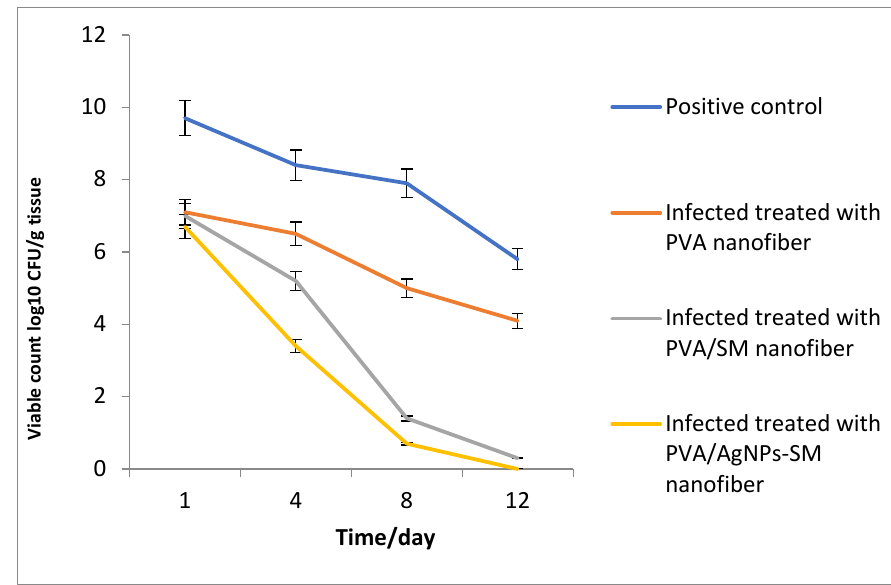
Figure 9. Bacterial cell load for the treated P. aeruginosa wound infections.